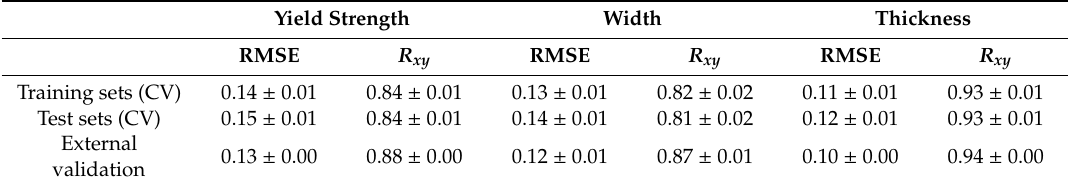
Table 7. RMSE and R xy criteria ( µ ± σ ) in cross-validation (CV) and external validation sets for each strip property by using multiple linear regression.